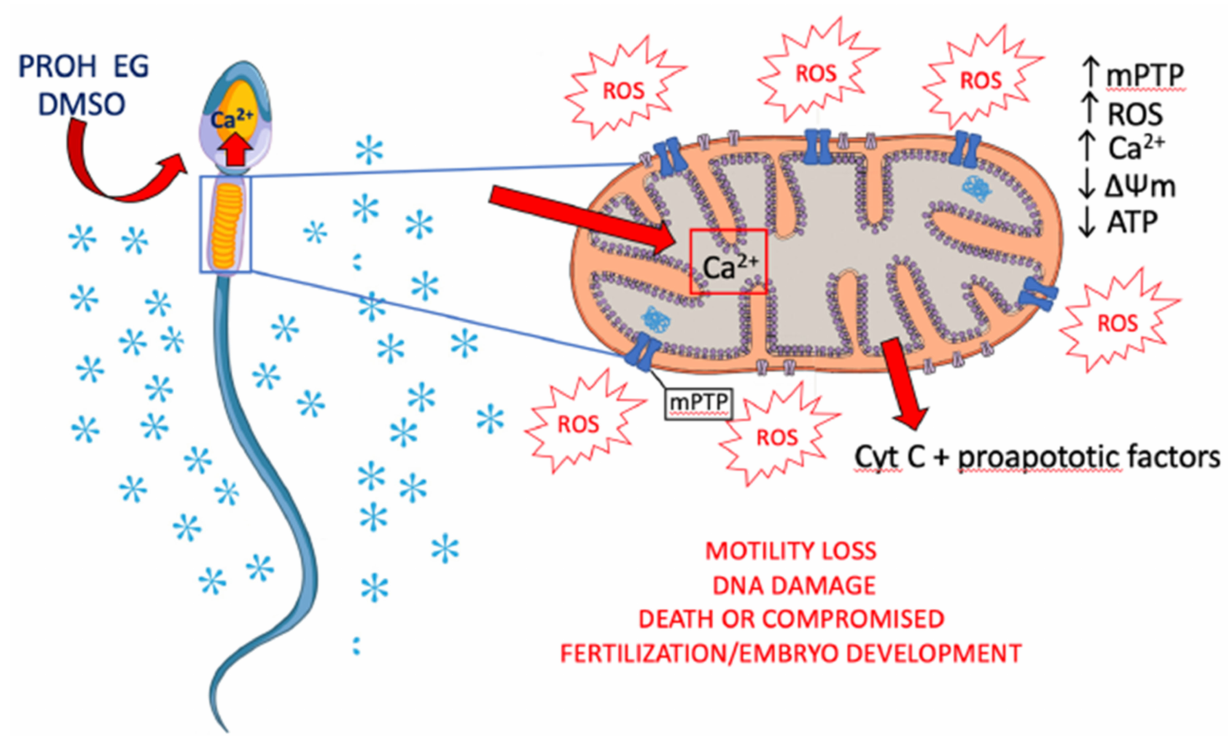
Figure 2. Possible mechanisms of sperm mitochondrial dysfunction associated with cryopreservation. Exposure to permeant cryoprotectants cause intracellular Ca 2+ increase. Prolonged openings of mPTP due to Ca 2+ overload trigger ROS and Ca 2+ release, loss of ∆Ψ m, decreased ATP content, and release of Cyt C. Such events may culminate in DNA damage and apoptosis. Depending on the extent of mitochondrial damage, the sperm can die or survive to cryopreservation. Oocytes fertilized by survived, DNA damaged sperm, could hesitate into a compromised embryo development. PROH, propanediol; EG, ethylene glycol; DMSO, dimethyl sulfoxide. Modified from https://www.vecteezy.com/vector-art/1434164-human- sperm-or-spermatozoa-cell-structure (accessed on 28 December